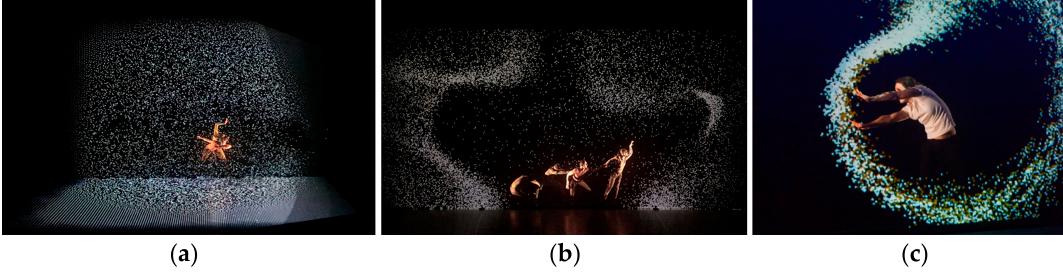
Figure 7. An amazing interaction between technical device and artists: the ballet Pixel , 2016 (Armand Amar, composer; Mourad Merzouki, choreograph; Adrien Mondot & Claire Bardainne, videomapping; Käfig and Centre Chorégraphique National de Créteil et du Val-de-Marne,